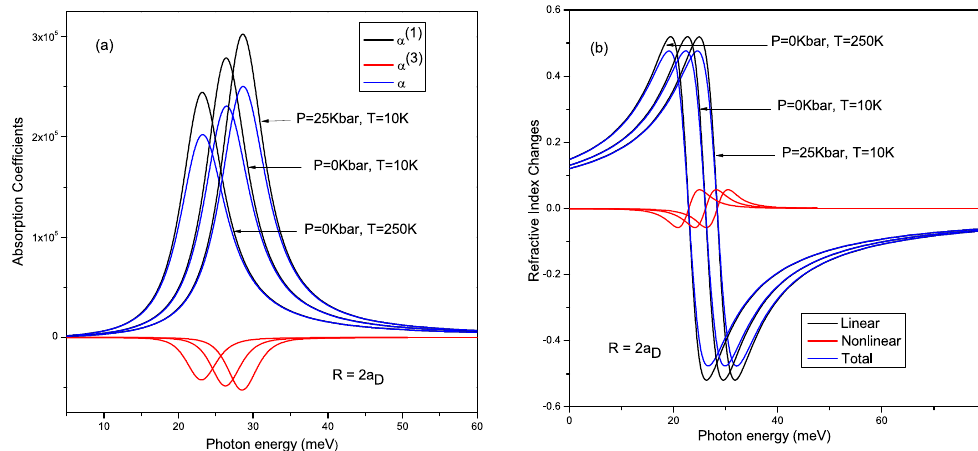
Figure 3. The absorption coefficients ( a ) and the refractive index change ( b ) as function of incident photon energy ¯ h ω for P = 0, P = 25 kbar , T = 10, T = 250 K and for 2 a D .